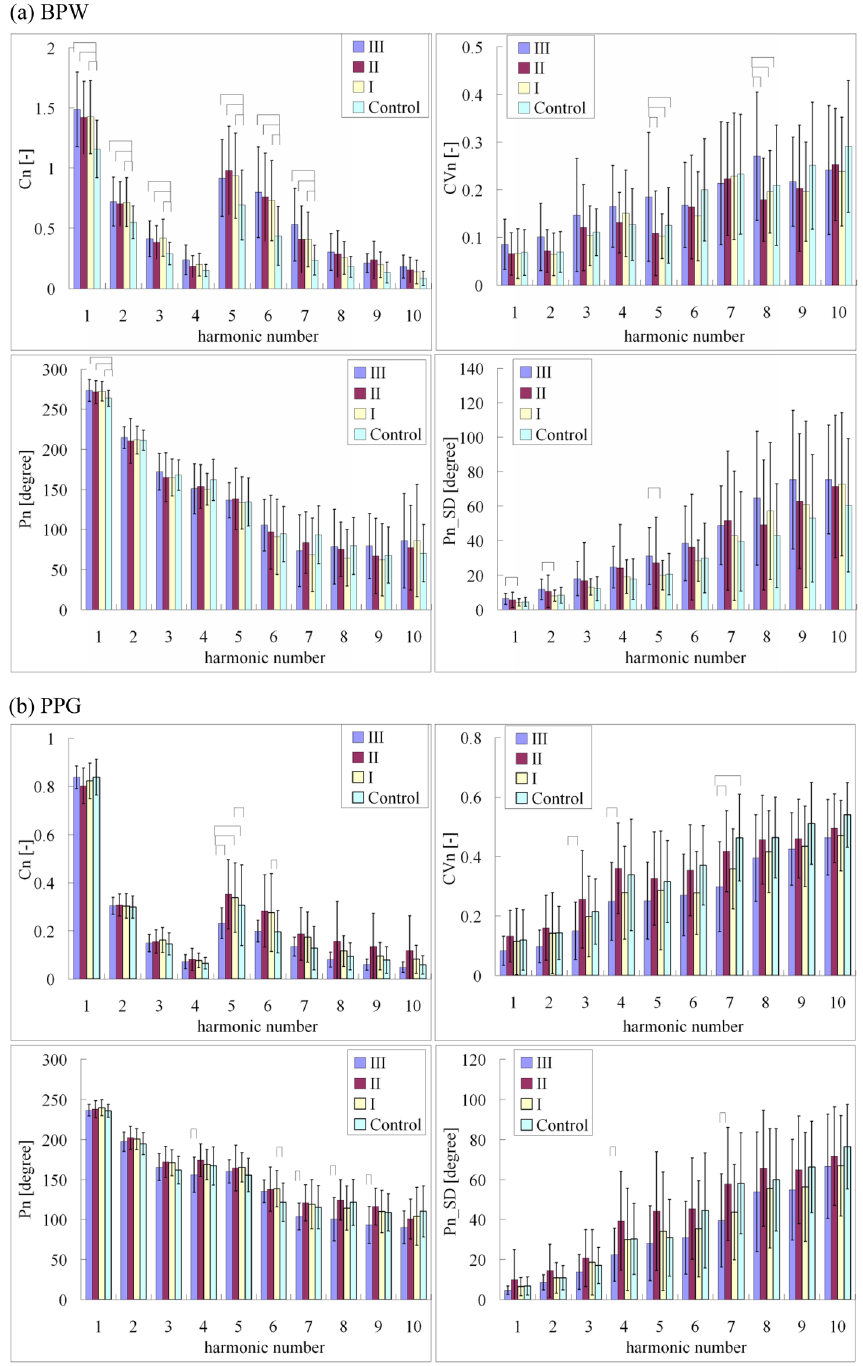
Figure 3. Comparisons of ( a ) BPW and ( b ) PPG harmonic indices between patients with severe AD (Group III), moderate AD (Group II), and mild AD (Group I), and control subjects: C n , CV n , P n , and P n _ SD . Data are mean and standard-deviation values. C 5 – C 10 values have been multiplied by 5 to make the differences clearer. “ ⌢ ” indicates p < 0.05. For BPW indices, C 1 – C 3 , C 5 – C 10 , and P 1 were significantly larger in Group III than the control subjects. CV 5 and CV 8 were significantly larger in Group III than in Group II, Group I, and the control subjects. For PPG indices, there were significant differences between Groups II (moderate AD) and III (severe AD) in C 5 , CV 3 , CV 4 , CV 7 , P 4 , P 7 , P 8 , P 9 , P 4 _ SD , and P 7 _ SD